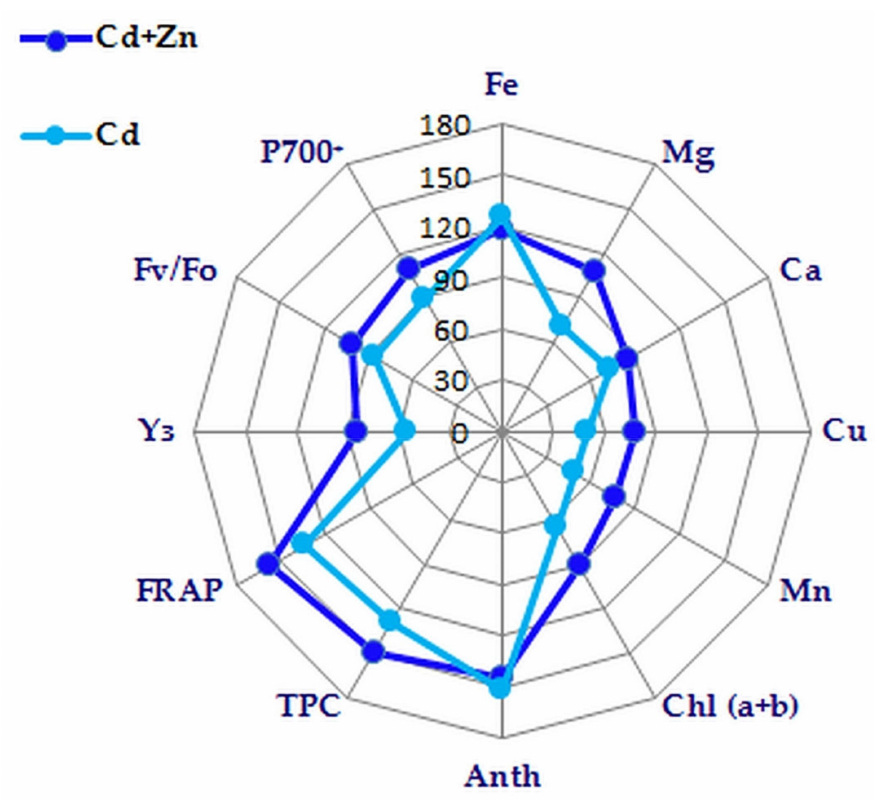
Figure 6. Summary of the Cd-induced changes ( p < 0.05) with and without an excess Zn supply in some studied parameters of Salvia sclarea presented as % from the respective control values: the leaf content of Fe, Mg, Ca, Cu, and Mn; the leaf content of total chlorophyll (Chl a+b ), anthocyanins (Anth), and total phenolics (TPC); the total antioxidant activity (FRAP); the maximum oxygen flash yields ( Y 3 ) and Fv/Fo ratio corresponding to oxygen-evolving activity; the PSI photochemical activity (P700 +